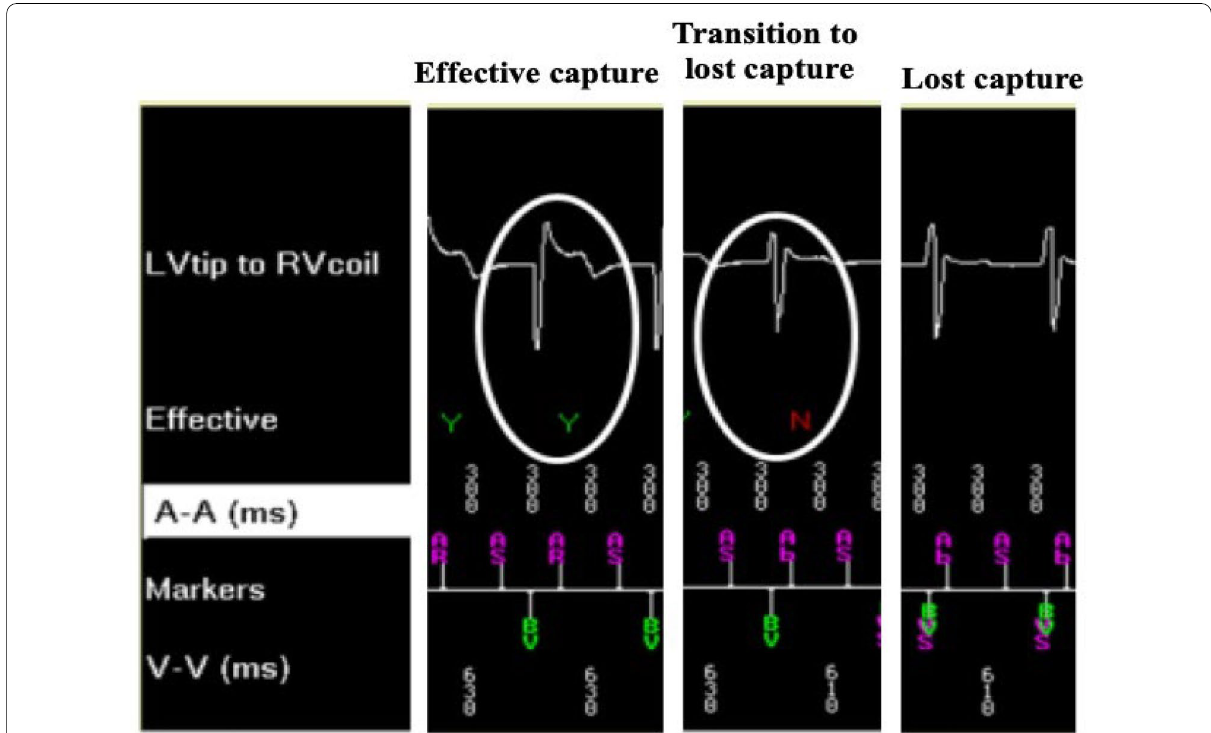
Fig. 1 Left ventricle capture confirmation by “EffectivCRT” algorithm. Dedicated unipolar LV EGM (LV cathode–RV coil EGM) during biventricular or LV pacing; until the third paced beat a “ Qr” morphology indicate the effective LV capture; the fourth beat represent a kind of fusion and the further beats are represented by an “ rS” morphology indicating the loss of LV capture. (with permission by Medtronic). LV left ventricle; RV right ventricle; Y LV effective OK; N loss of LV effective capture; AS atrial sense; Ab atrial blanking; VS